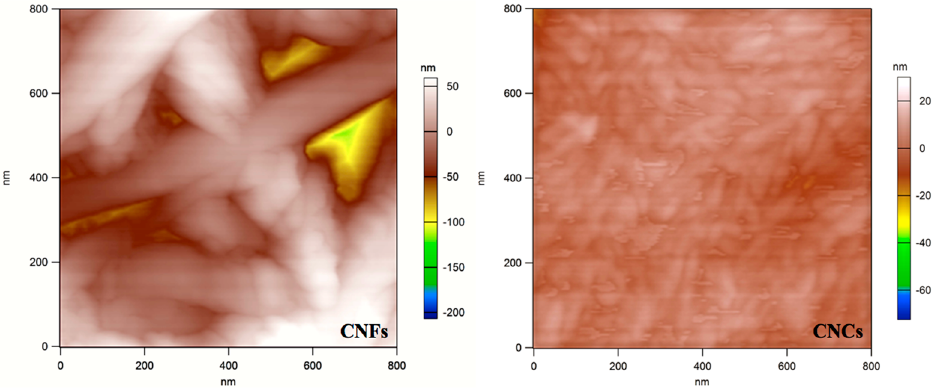
Figure 1. Representative AFM images of CNF and CNC samples.